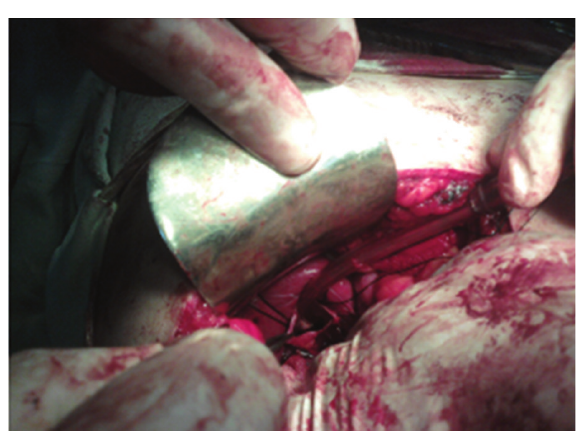
Although the occurrence of retroperitoneal bron- chogenic cyst is rare, it should be considered in the di ff er- ential diagnosis of a cystic lesion in the region adjacent to the